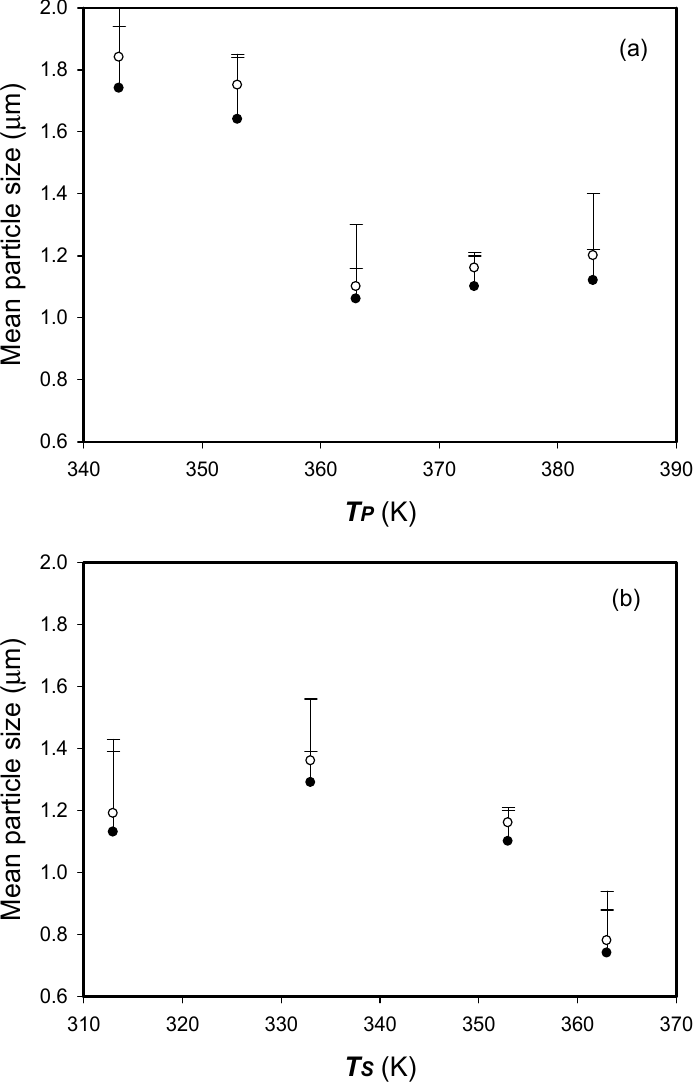
Figure 3. Arithmetic mean size ( d no , ) and mass-weighted mean particle size ( d 4,3 , ) of the HP- β -CD particles varying with SAA process parameters of ( a ) the temperature of precipitator ( T P ) ( b ) the temperature of saturator ( T S ).